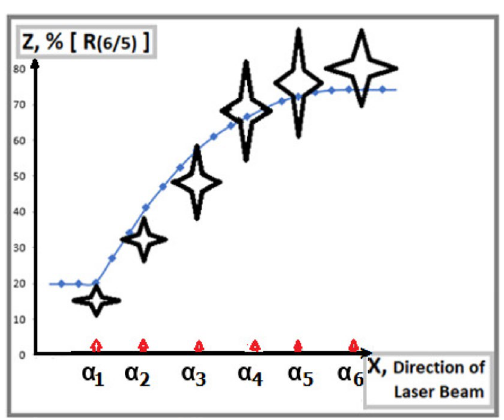
Figure 4. A relative luminance of neighboring interference fringes in the vicinity of the main minima vise- versa horizontal directions of a laser beam: A correlation of experimental ratio R ( 6 / 5 ) Fraunhofer approximation curve is also consistent with the increasing contribution of I 2